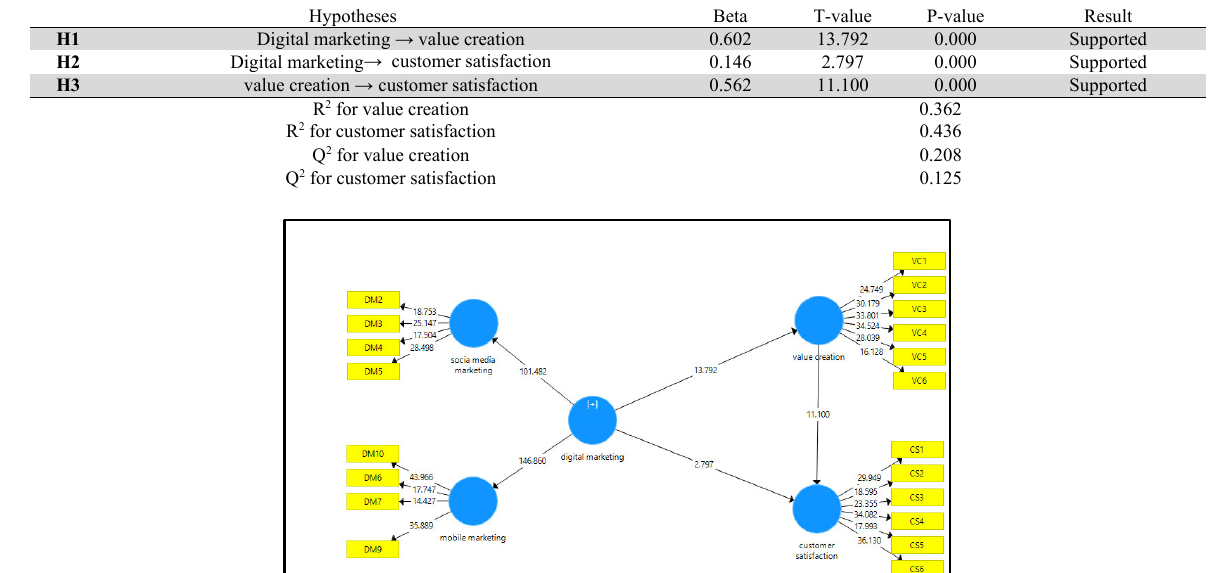
Fig. 1. Structural Research